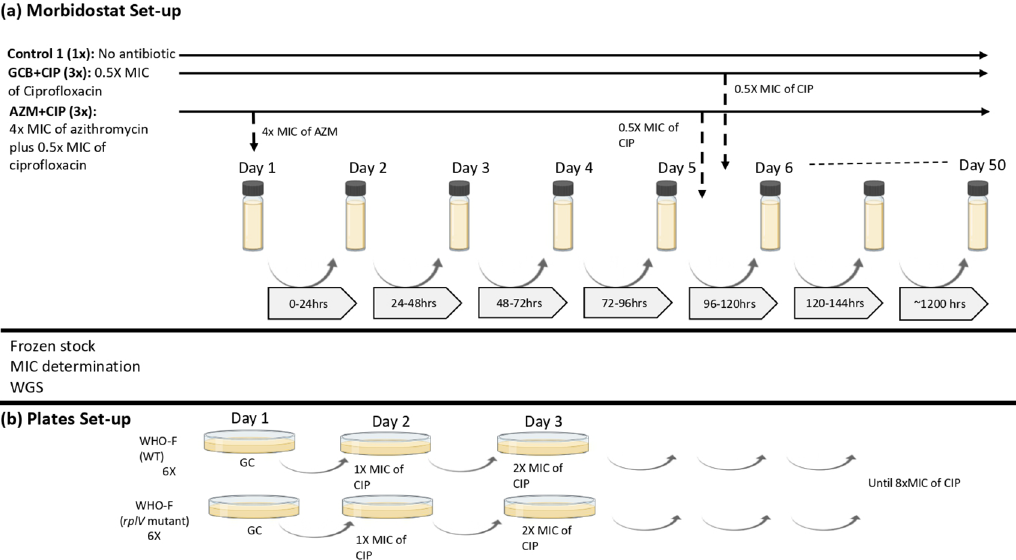
Figure 1. Visual scheme of the experimental set-up. (a) Morbidostat set-up: N. gonorrhoeae WHO-F strain is grown in two different conditions: GCB+CIP (3 (cid:1) ), population grown in GC broth without antibiotic for 5 days followed by exposition to ciprofloxacin for 28 days (n=3; vial 4, vial 5, vial 6). AZM+CIP (3 (cid:1) ), population grown in GC broth with azithromycin antibiotic for 5 days followed by exposition to 0.5 (cid:1) MIC of ciprofloxacin for 50 days (n=3; vial 1, vial 2, vial 3). The concentration of ciprofloxacin doubles during the 50 days that the experiment is elapsing. Control (1 (cid:1) ), population without antibiotic grown in GC broth for 27 days (b) Plates set-up: Isolates (n=2; WT and rplV mutant) from the morbidostat analysis were plated by increasing the concentrations of ciprofloxacin until the MIC reached >32 mg/L or until no visible growth was seen. (GCB: Gonococcal broth; CIP: Ciprofloxacin; GC: Gonococcal; AZM: Azithromycin; MIC: Minimum inhibitory